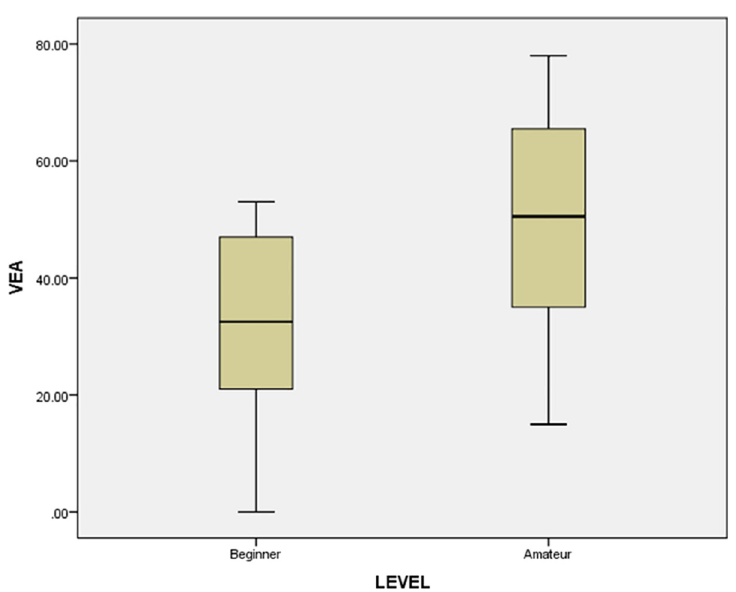
Fig 13. VEA mean score graph of beginner versus